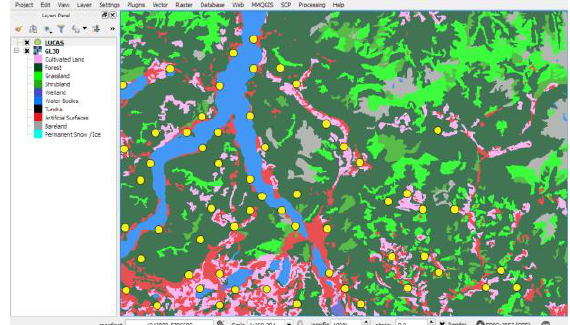
Figure 7. Screenshot of QGIS showing the pre-processed GL30 and LUCAS datasets in Lombardy Region, Italy.